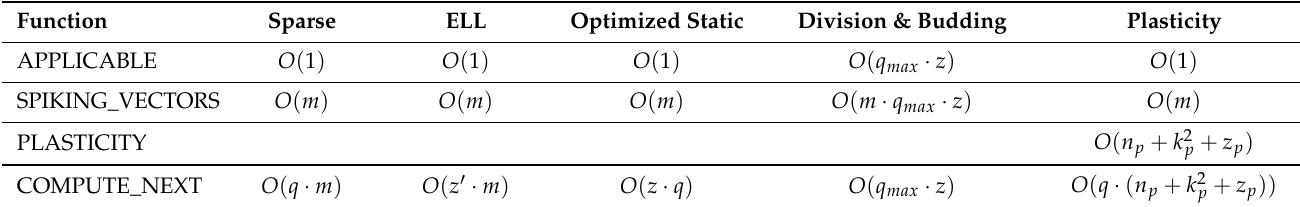
Table 3. Algorithmic order of complexity of the main functions employed in the simulation loop (i.e., excluding init functions) for each